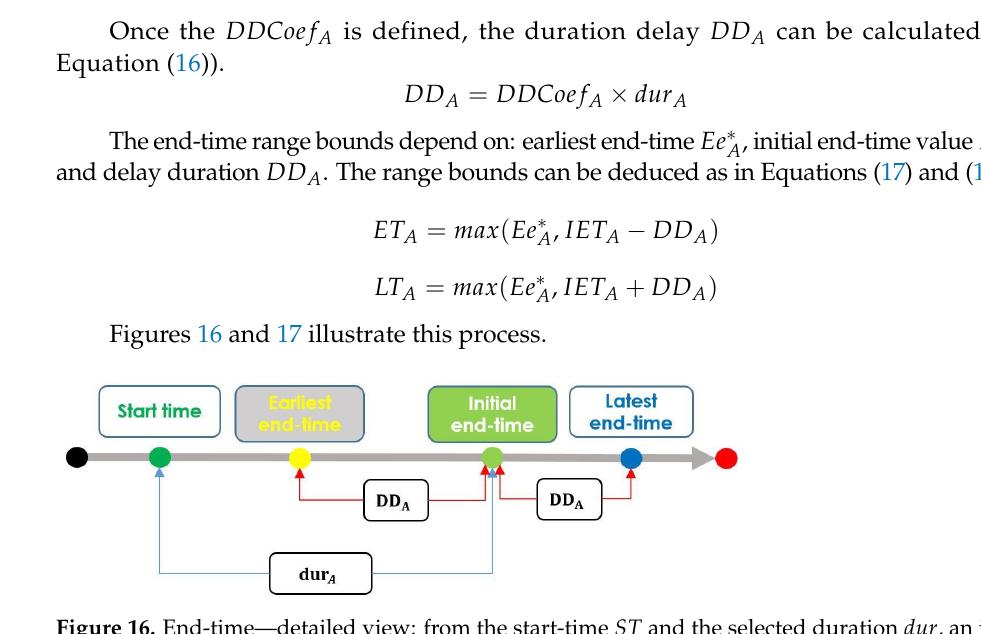
Figure 16. End-time—detailed view: from the start-time ST and the selected duration dur , an initial end-time value is calculated; when the tolerance coefficient is included, a tolerance (delay) duration DD is then estimated, which combines with the initial end-time value to define the end-time range.